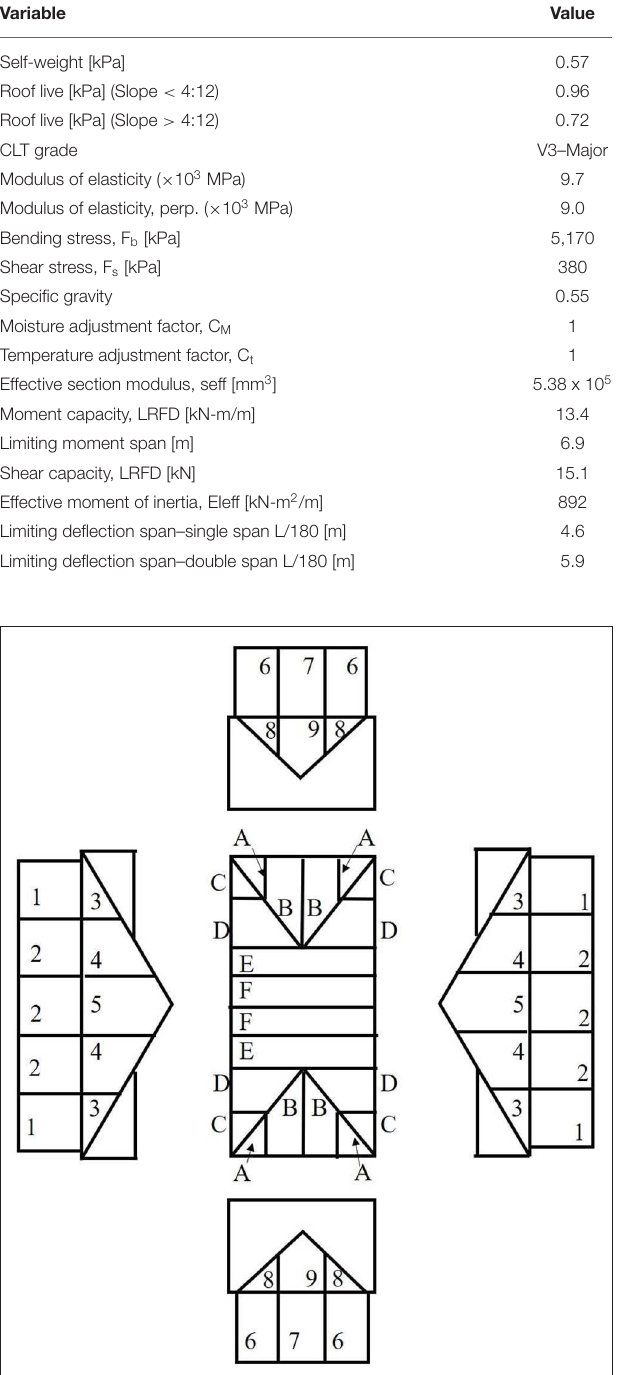
FIGURE 2 | Panel layout of structure